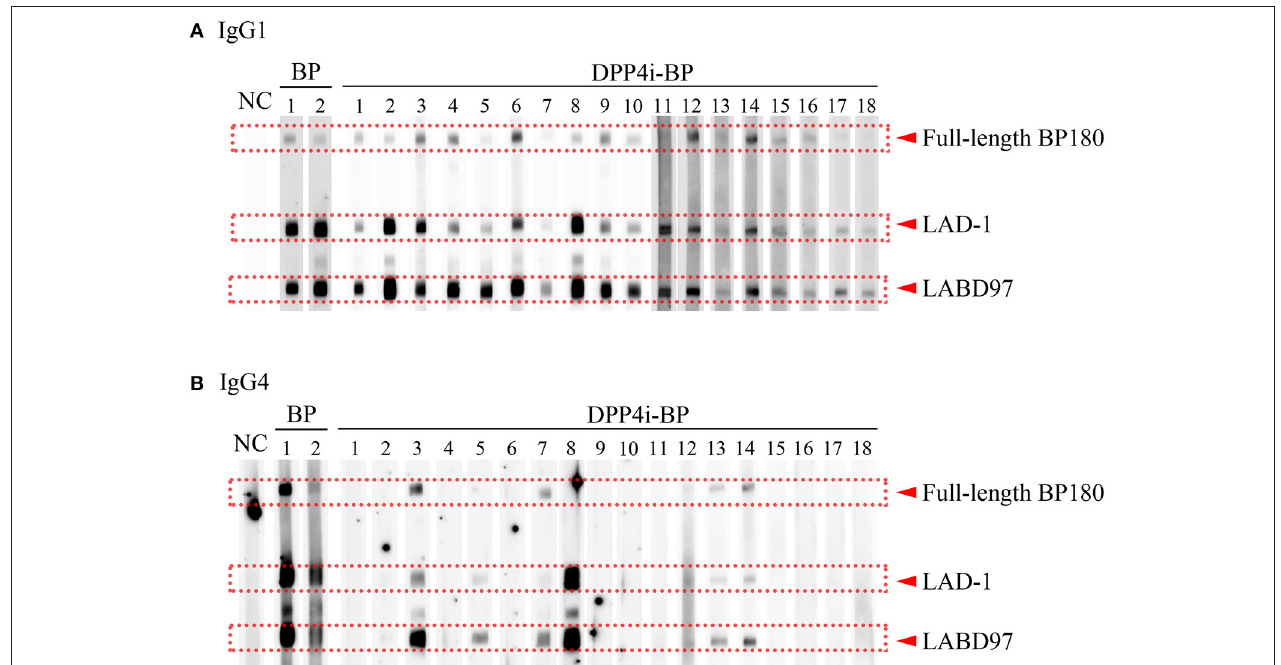
FIGURE 2 | IgG subclass analysis of DPP4i-BP. Detection of IgG1 (A) and IgG4 (B) autoantibodies by Western blot using a mixture of full-length recombinant BP180 and plasmin-digested BP180